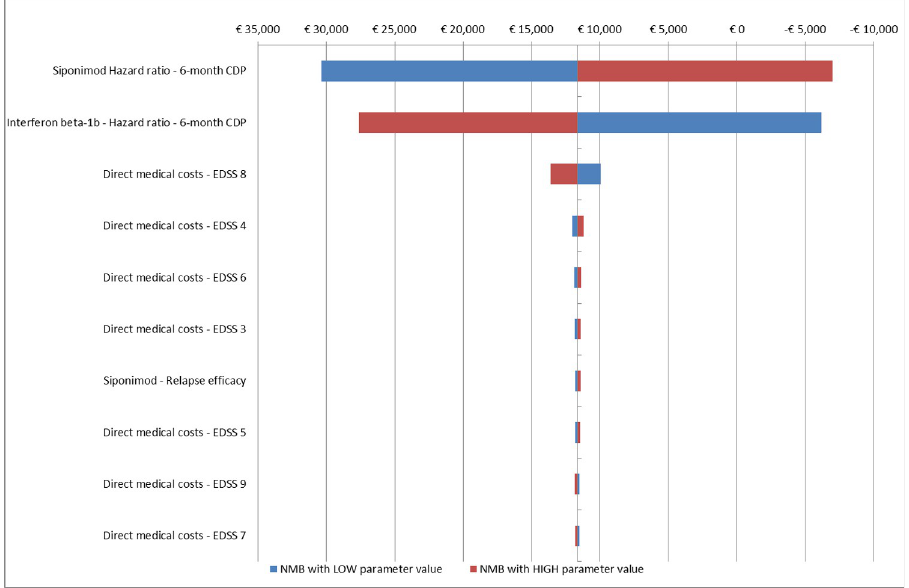
Fig 2. One way sensitivity analysis of cost effectiveness of siponimod compared with Interferon beta-1b.